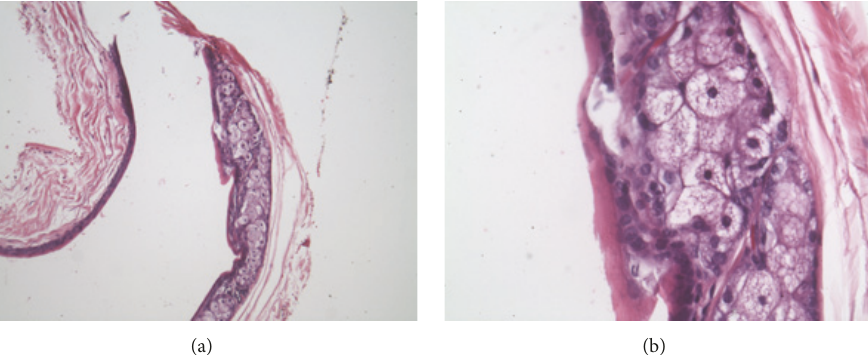
Figure 2: Representative photomicrograph of a steatocystoma stained with hematoxylin and eosin (H&E) at 100x (a) and 400x (b) magnification. Abundant sebaceous input is clearly visible in the cyst wall.